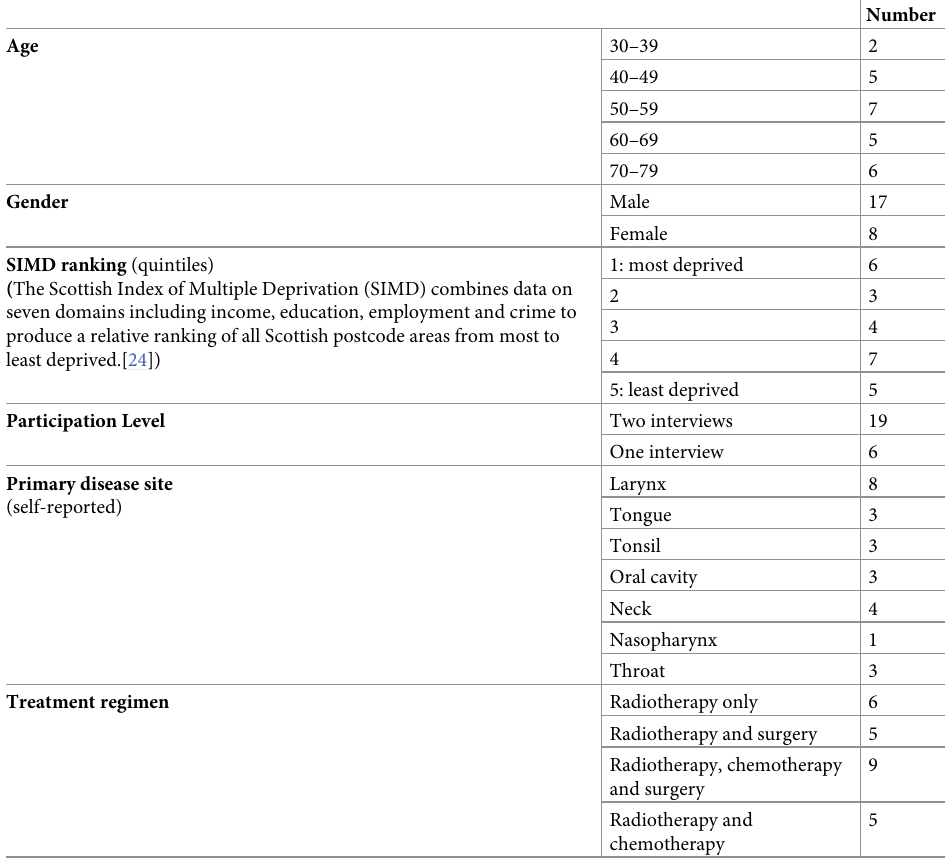
SIMD ranking (quintiles) ( The Scottish Index of Multiple Deprivation (SIMD) combines data on seven domains including income, education, employment and crime to produce a relative ranking of all Scottish postcode areas from most to least deprived.[24])